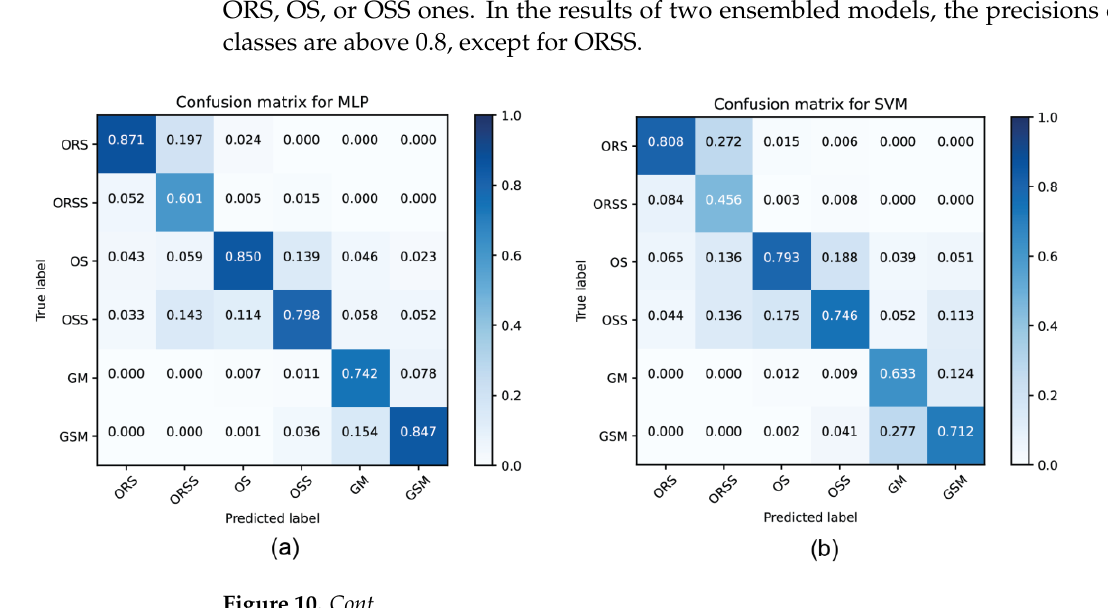
Figure 10. Confusion matrix of lithofacies prediction on test datasets by MLP ( a ), SVM ( b ), Random Forest ( c ), and XGBoost models ( d ). Refer to text for abbreviations of lithofacies. 5. Discussion 5.1. Comparison of the Performances of Machine Learning Models in Shale Lithofacies Prediction from Well Logs The performances of ensemble methods (Random Forest and XGBoost) surpass those of MLP and SVM, with the highest accuracy of 0.884 predicted by Random Forest (Figure 10). SVM shows the lowest accuracy among the four models, with an accuracy of 0.723. For the Random Forest and XGBoost models, clay-rich lithofacies (ORS, OR, and GM) show a higher rate of accurate prediction than siliceous-rich lithofacies (ORSS, OSS, and GSM). This indicates that clay content is an important factor influencing the accuracy of lithofacies prediction from well logs. More than 80% of ORS can be predicted accurately in all four models, indicating that shale with high TOC and high clay contents has distinct features in the well log data, which makes it easier to be differentiated from other lithofa- cies. The lower rate of accurate prediction on ORSS may result from its feature that is not significant enough against ORS, OS, and OSS. A test well is used to evaluate the generalization capability of the models. We used the random forest model, which has the best performance in our study, to predict the lithofacies along the depth of the test well. The comparison between the ground truth and predicted lithofacies is illustrated in Figure 11, and the performance matrix is reported in Table 4. The accuracy of the random forest model on the test well is 0.867, indicating a